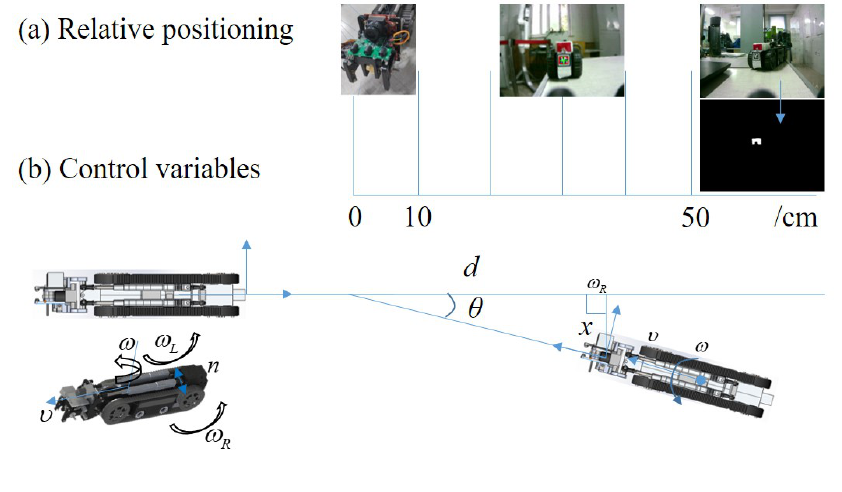
Figure 9. Relative positioning, and controllable and measured space in